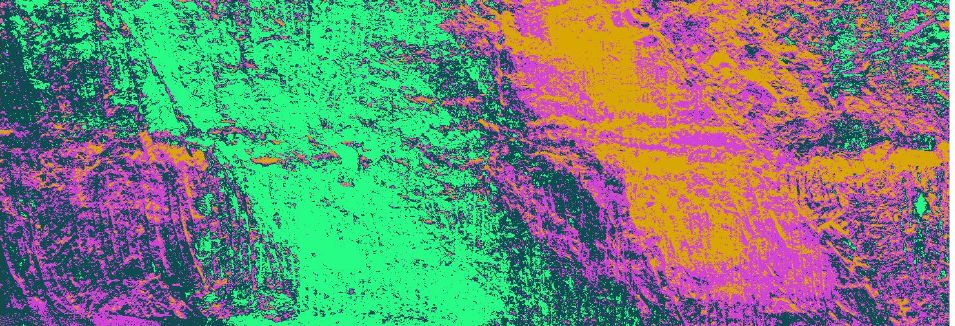
Figure 9. Coloured cluster map of the Top Pit orthomosaic using ISO Cluster Classification Tool for four classes.